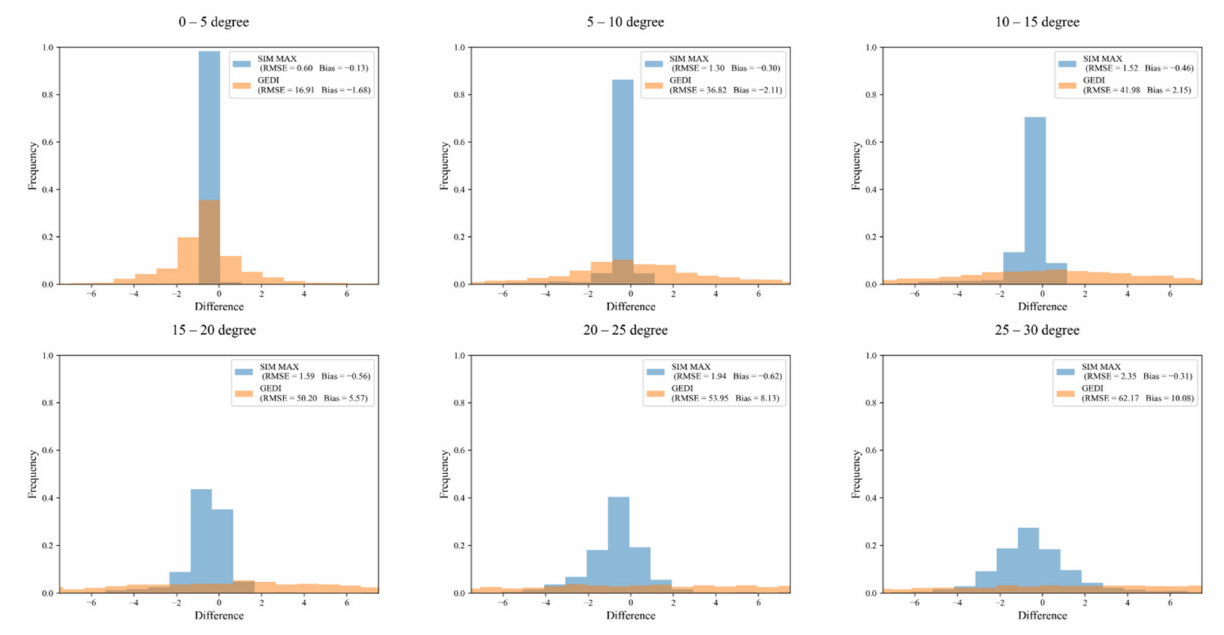
Figure 8. Ground elevation residuals for simulated (Maximum algorithm, blue) and real (orange) GEDI observations. A positive difference indicates an